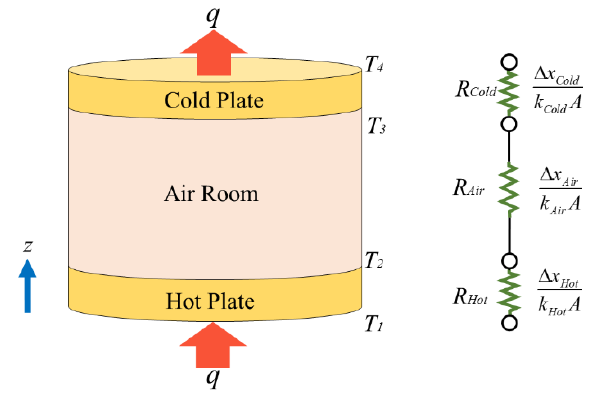
Figure 1. One-dimensional heat transfer (conduction only) through the GSCH and electrical analog.